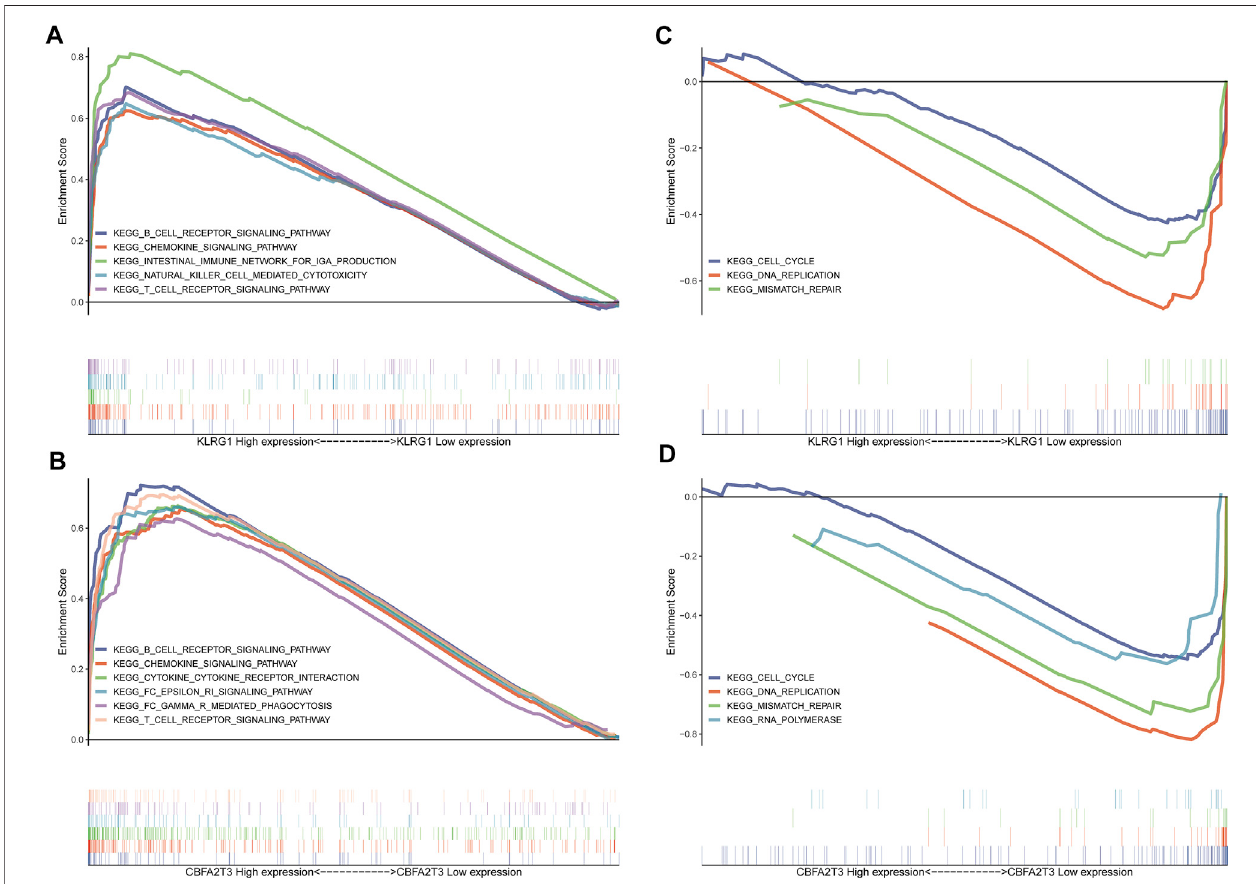
FIGURE 3 | Expression of tumor antigens is associated with a variety of immune pathways and cell cycle pathways (A – B) Patients with high expression of KLRG1 and CBFA2T3 have more active immune-related pathways. (C – D) Patients with low expression of KLRG1 and CBFA2T3 have a more active cell cycle.